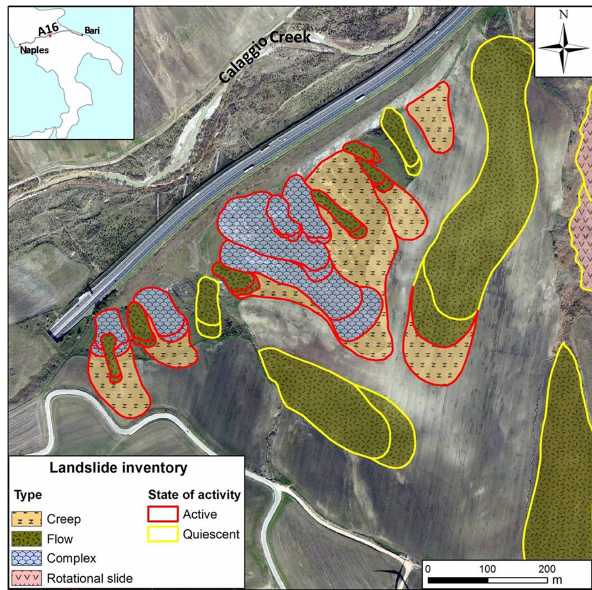
Figure 2. Landslides detected through field survey along the moni- tored section of A16